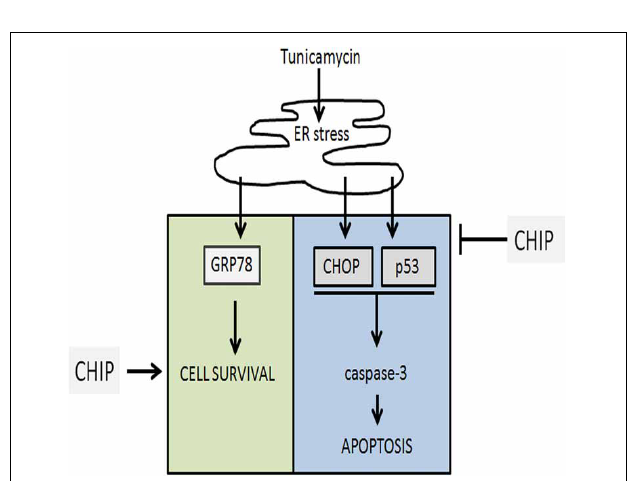
FIGURE 9 | BIP/GRP78 expression is not altered after Tunicamycin treatment in slices overexpressing CHIP. (A) Western blots for BIP/GRP78; ERK-2 used as loading control. (B) Quantification for optical density (O.D). Values represent ± S.E.M. compared to vehicles. P < 0 . 05, C.I.: 95%, N = 3 independent experiments.